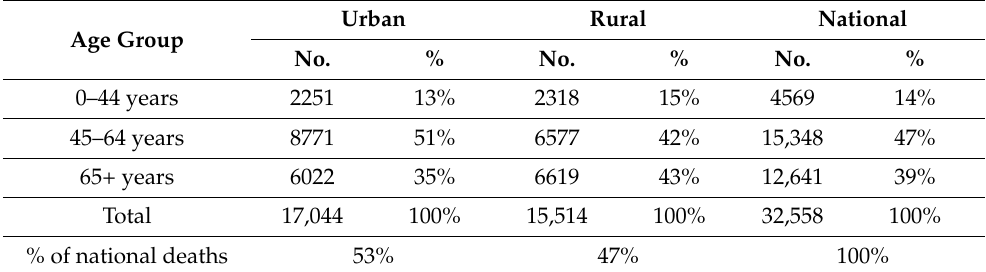
Table 2. Cumulated deaths by age groups and rural–urban areas, 2001–2019.